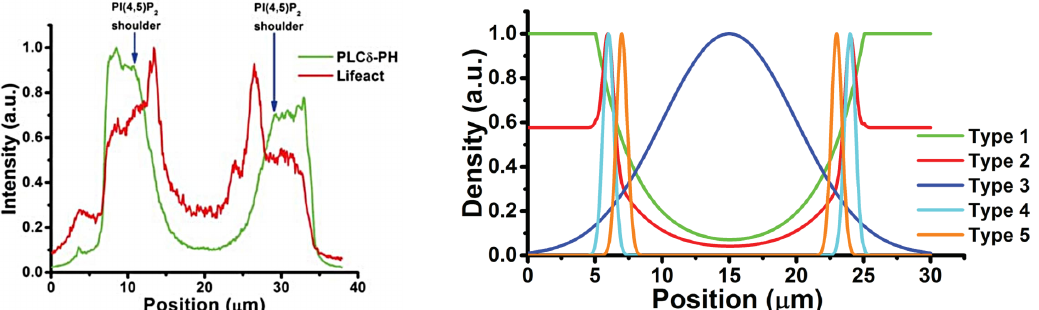
Figure 12. Left: A cross-section of an actin wave, showing actin (red) and PIP2 (green). The drop in PIP2 occurs at the boundary of the cell. Right: The spatial profiles of components in the wave, all normalized to their maximum value in the wave. Components were classified into 5 types, based on their pattern of in the waves: Type 1—Cortical actin, PI(4,5)P2, PI5K; Type 2—Total F-actin; Type 3—PI(3,4)P2, DAG; Type 4—Branched actin, N-WASP Type 5–SHIP2. Please note that PIP2 is constant in front of the wave. Taken from Masters et al. [76].